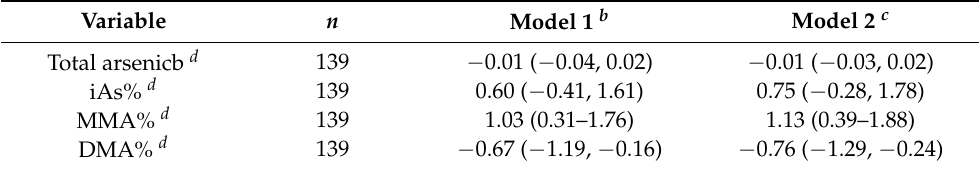
Table 3. Association ( β a (95% CI)) between urinary arsenic and metabolism indices and serum hemoglobin